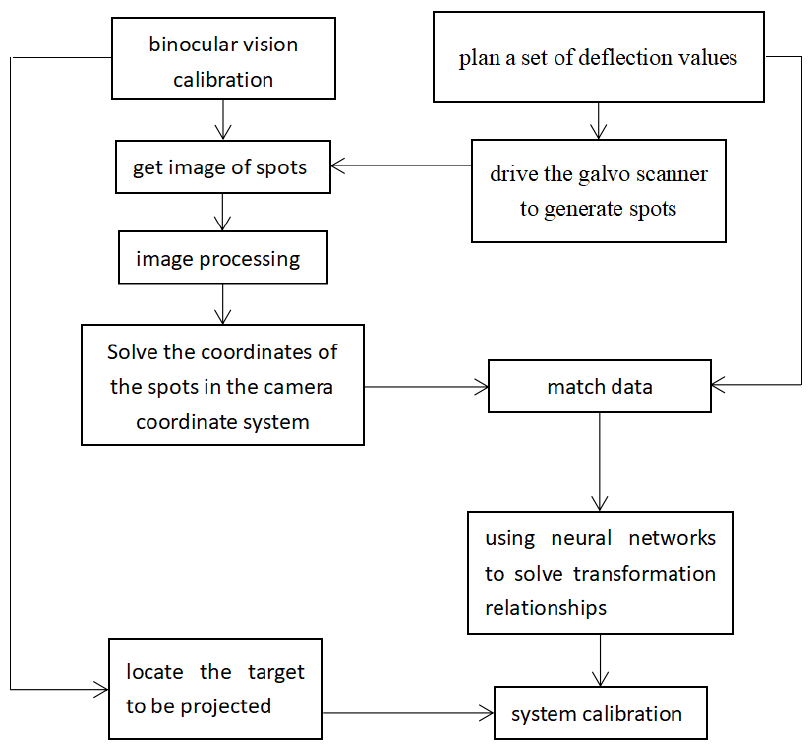
Figure 8. Calibration flow chart based on binocular vision.